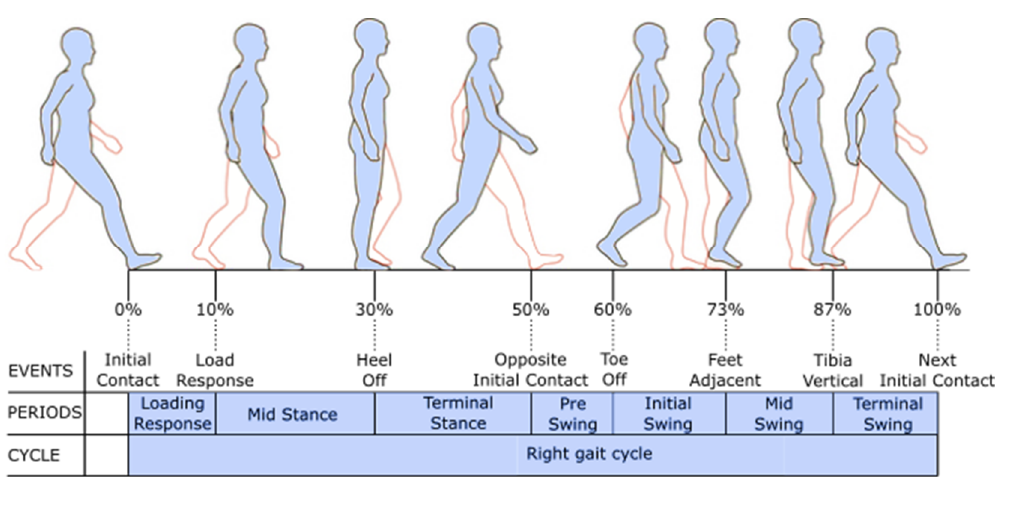
Figure 2. Concept: Lyra with IMUs and FES, adapted from